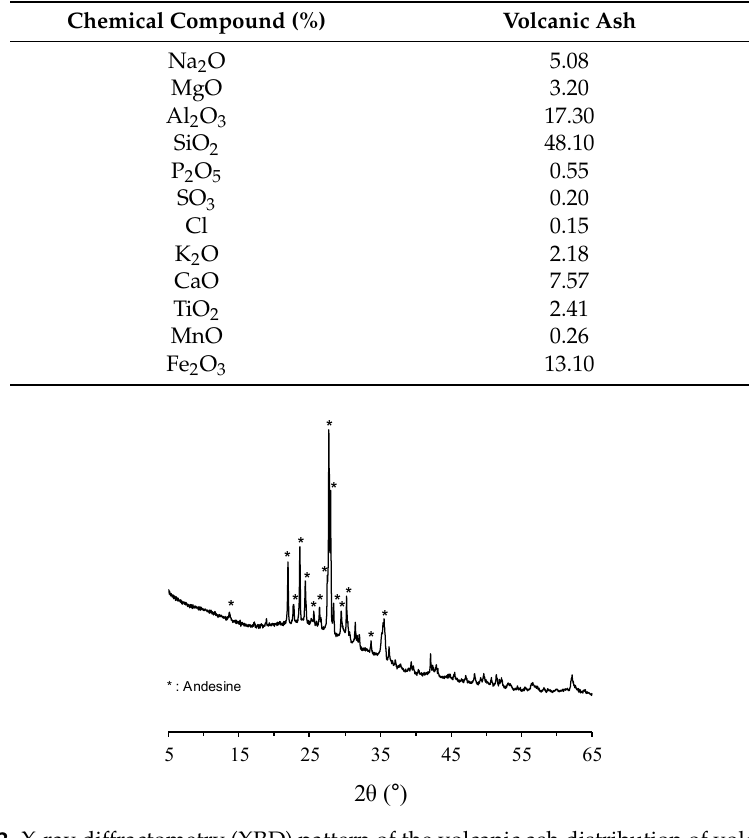
Figure 2. X-ray diffractometry (XRD) pattern of the volcanic ash distribution of volcanic ash. Table 3. Mixture proportion of samples expressed as mass